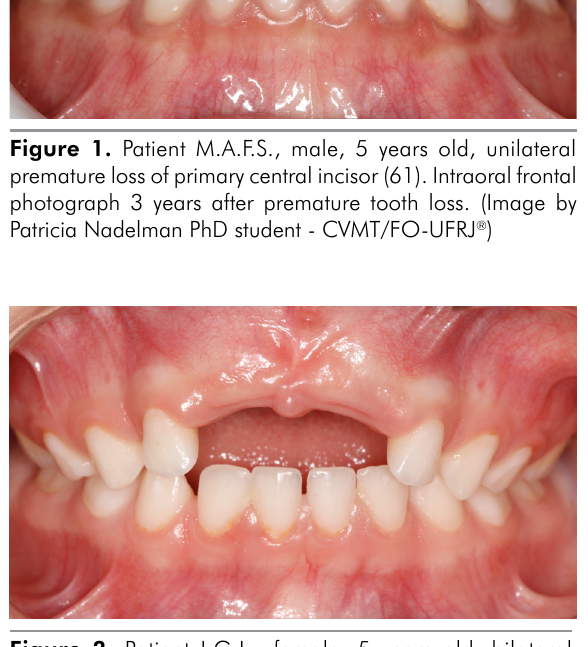
Figure 2. Patient I.G.L., female, 5 years old, bilateral premature loss of primary central incisors (51 and 61). Intraoral frontal photograph one year after the premature loss.